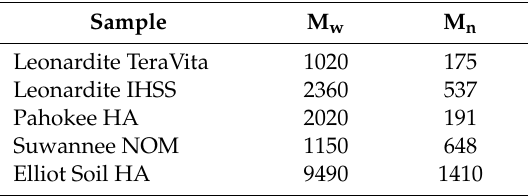
Table 1. The weight average (M w ) and number average (M n ) molecular weights for the humic substances as determined by SEC (Size exclusion chromatography) with detection at 280 nm are reported. Natural Organic Matter (NOM), TV: TeraVita, IHSS: International Humic Substances Society and HA: humic acid.